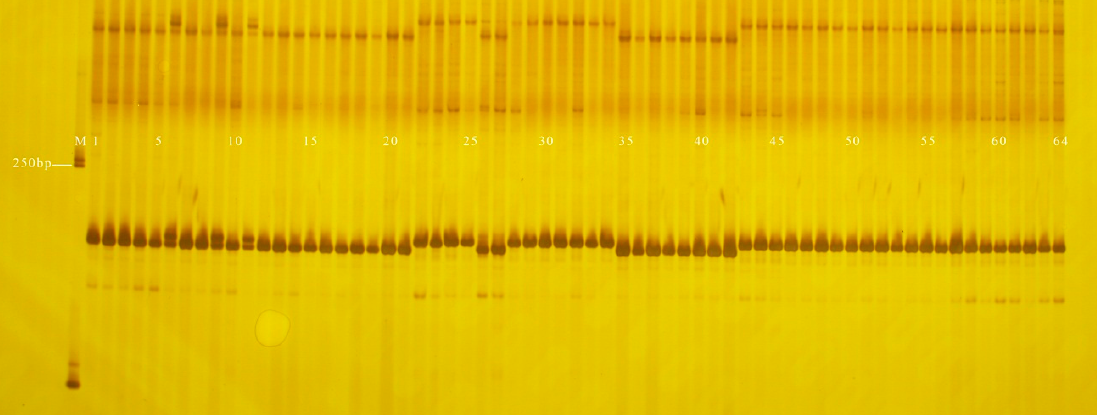
Figure 2. Amplification results of GX1 in some inbred line materials. M: DL2000 DNA Marker; 1–